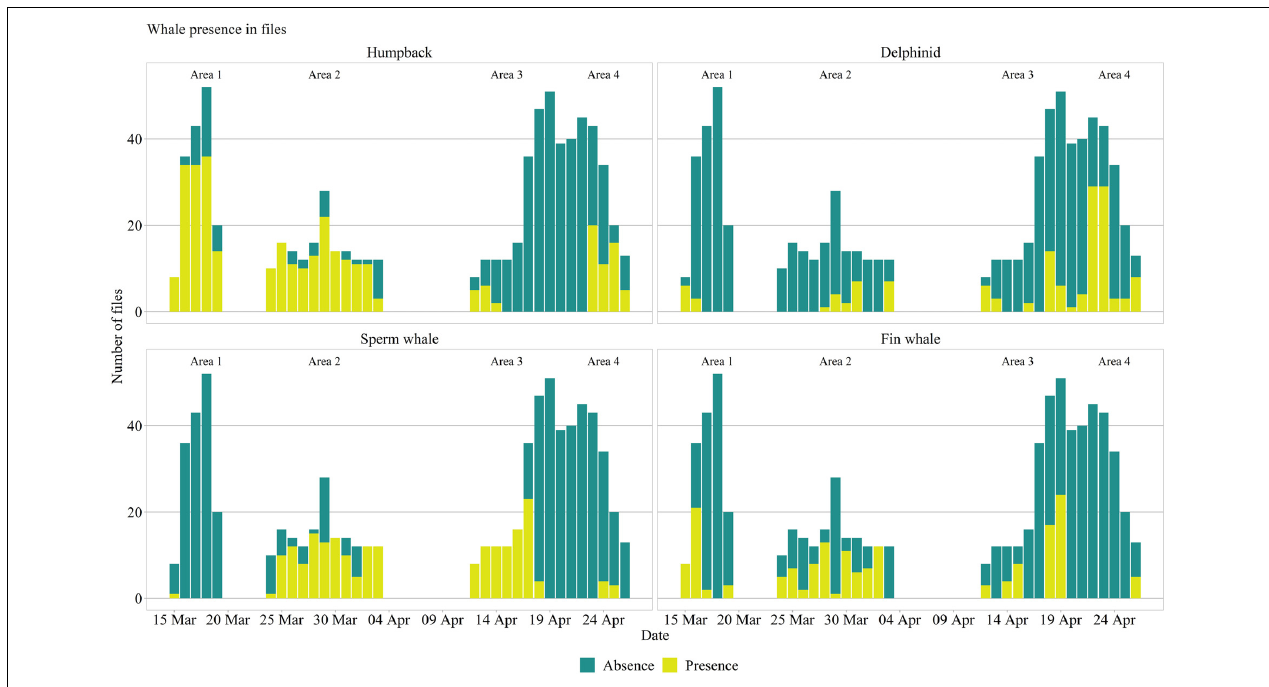
FIGURE 2 | Whale presence and absence detected in acoustic files per area.